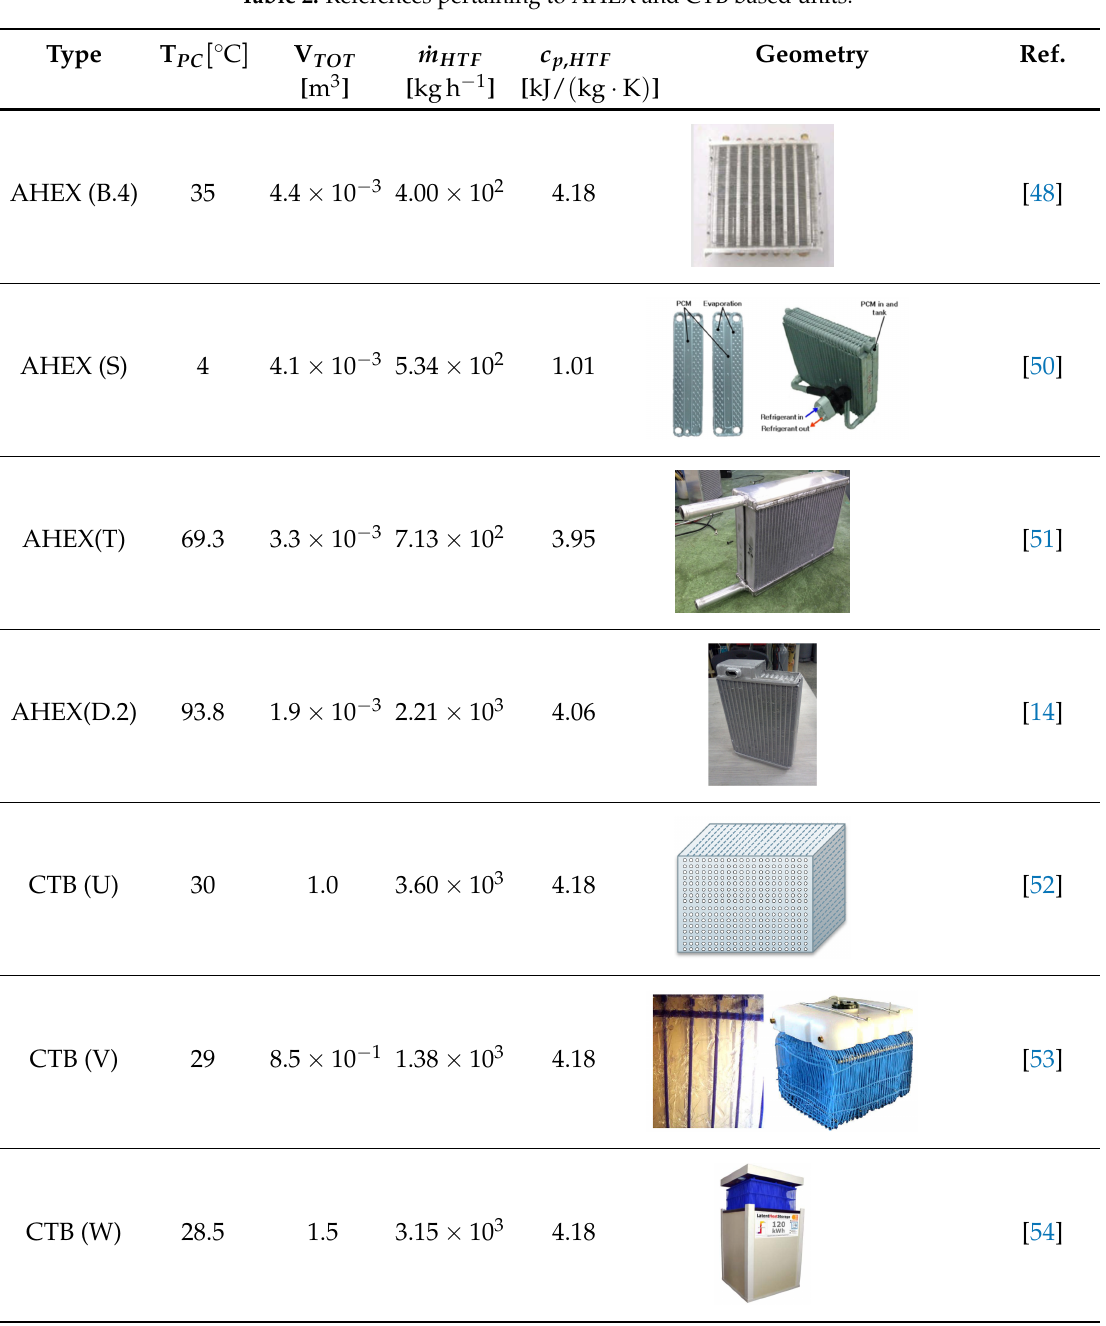
Table 2. References pertaining to AHEX and CTB based